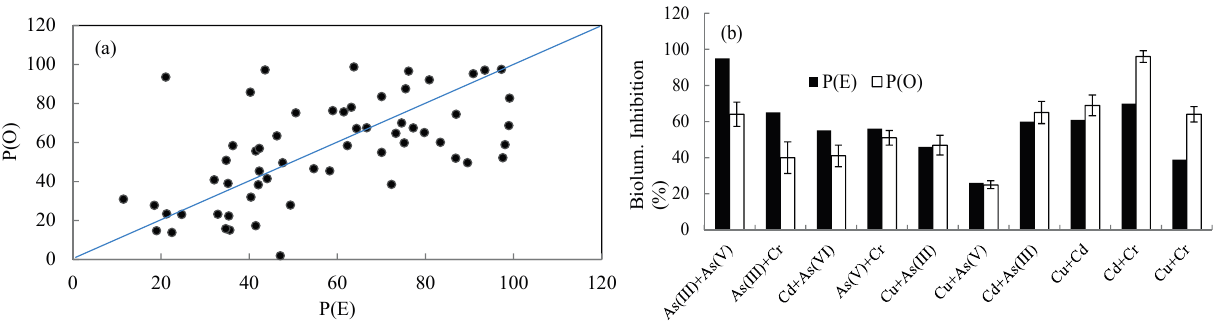
Figure 6. Correlations between theoretically expected and observed bioluminescence activities of KG1206 (mg/L) in the presence of binary mixtures of copper, cadmium, arsenite, arsenate, and chromate. Error bar indicates standard deviation. ( a ) Total combinations (#60); ( b ) average of each set (10 combinations per